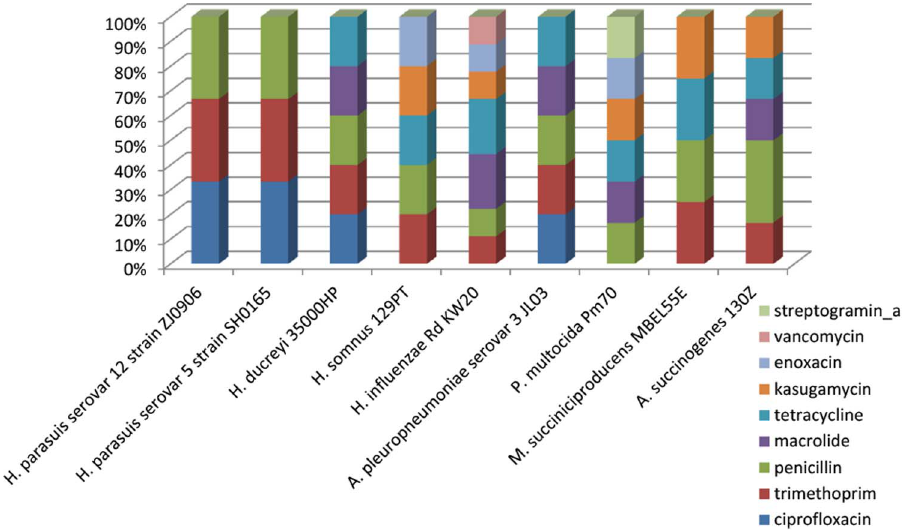
Figure 6. Comparative percentage of potential drug resistant genes. ARDB-annotated gene distribution of H. parasuis serovar 12 strain ZJ0906, serovar 5 strain SH0165, H. ducreyi 35000 HP, H. somnus 129PT, H. influenzae Rd KW20, A. pleuropneumoniae serovar 3 JL03, P. multocida Pm70, M. succiniciproducens MBEL55E and A. succinogenes 130Z were shown in percentage (in term of number). doi:10.1371/journal.pone.0068350.g006 PLOS ONE |